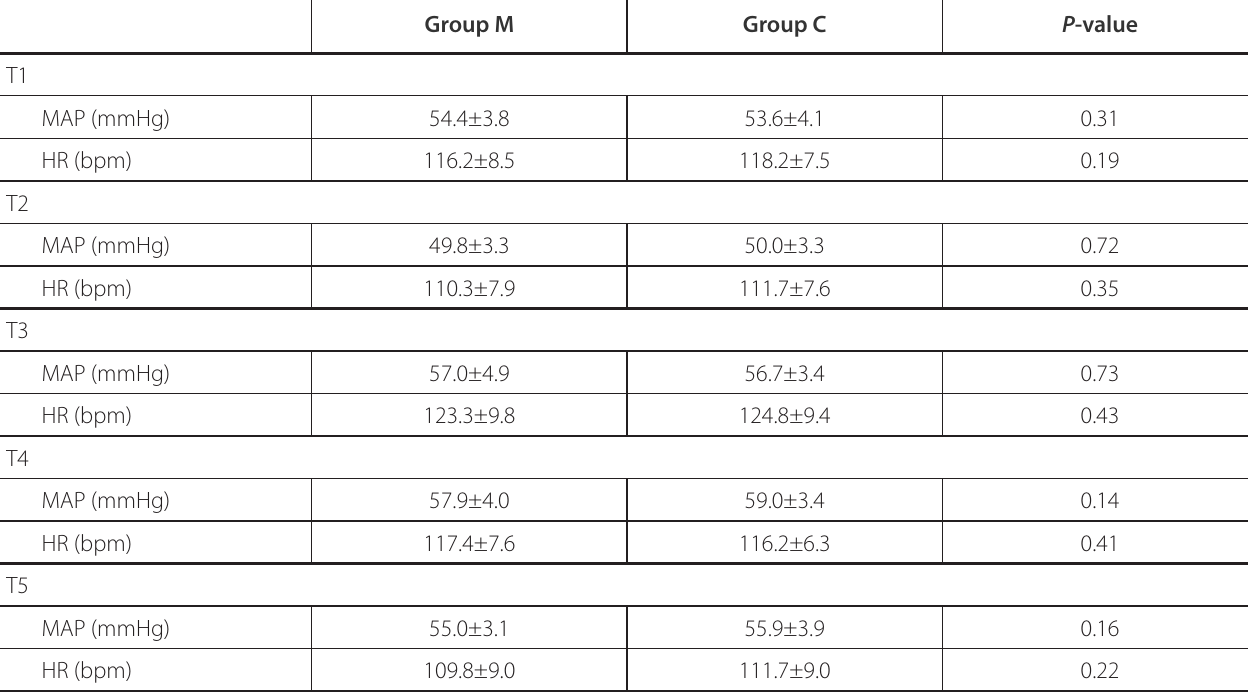
Table 2 . Comparison of perioperative hemodynamics of the two groups. Group M Group C P